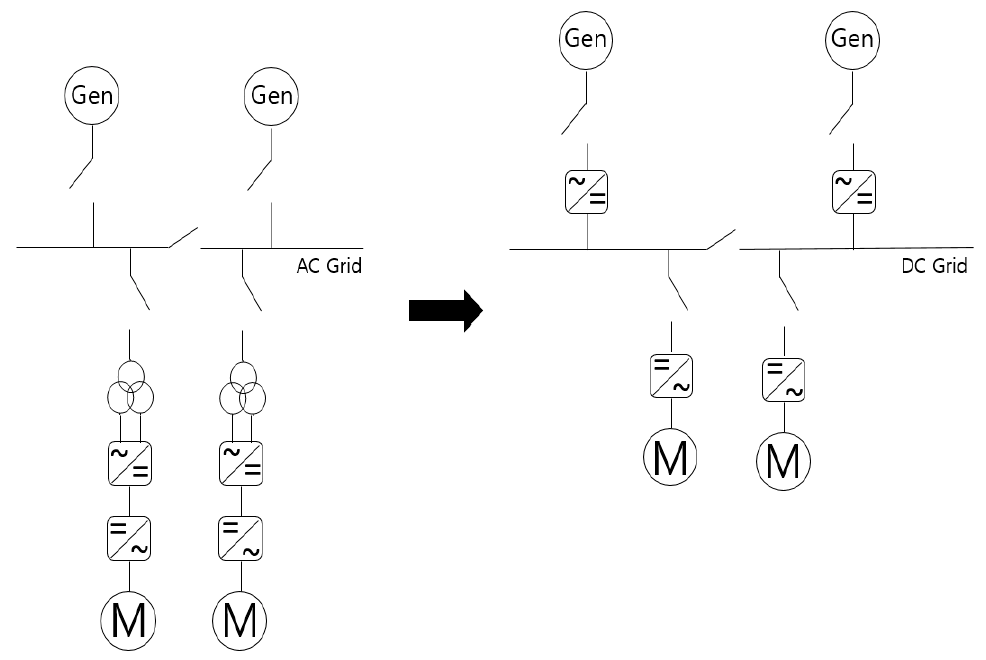
Figure 3. Comparison of distribution systems in electric propulsion system of ships .